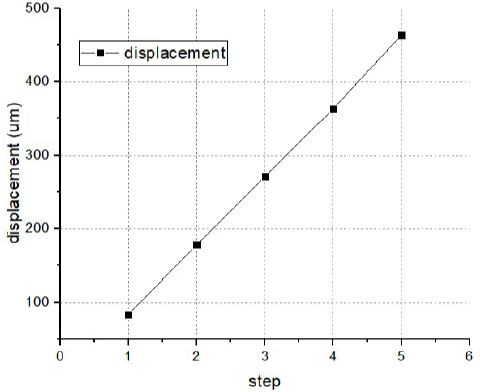
Figure 17. The output displacement versus the moving step.